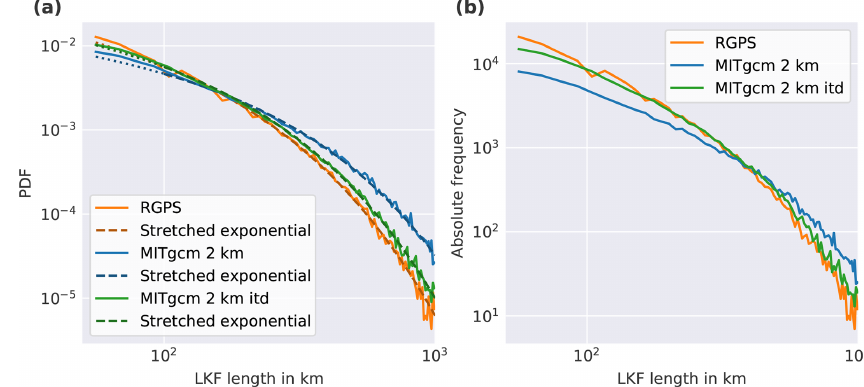
Figure 7. (a) PDF of LKF lengths for RGPS data and both simulations along with fits to stretched exponential distributions. (b) Absolute frequencies of LKF lengths in RGPS data and both simulations. For the analysis presented in this figure the LKF datasets of both simulations are filtered for RGPS